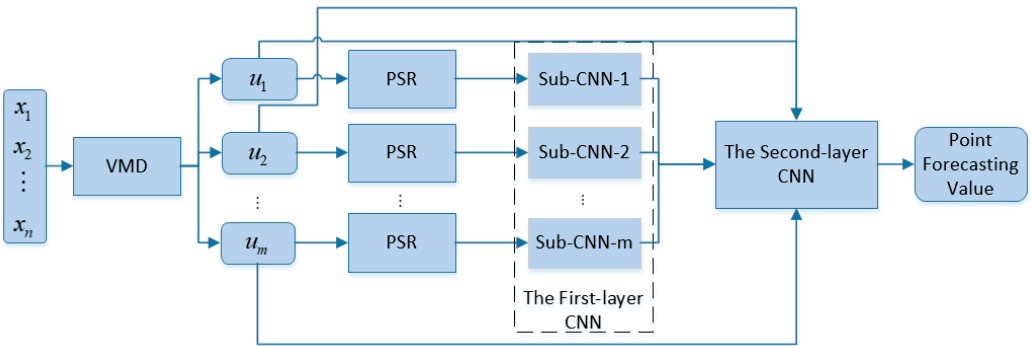
Figure 3. Schematic diagram of the proposed point-based forecasting model. VMD: variational mode decomposition; PSR: phase space